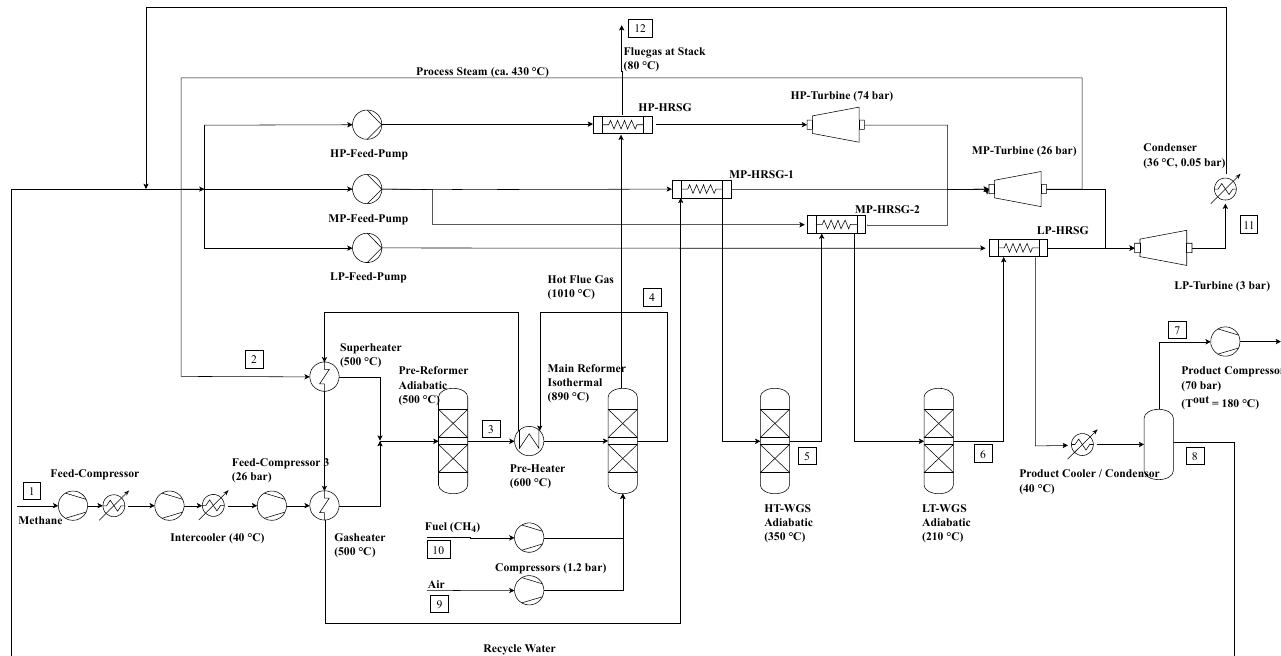
Figure 3. Process flow diagram of the SMR process (Stream details for flows 1–12 in Appendix E).